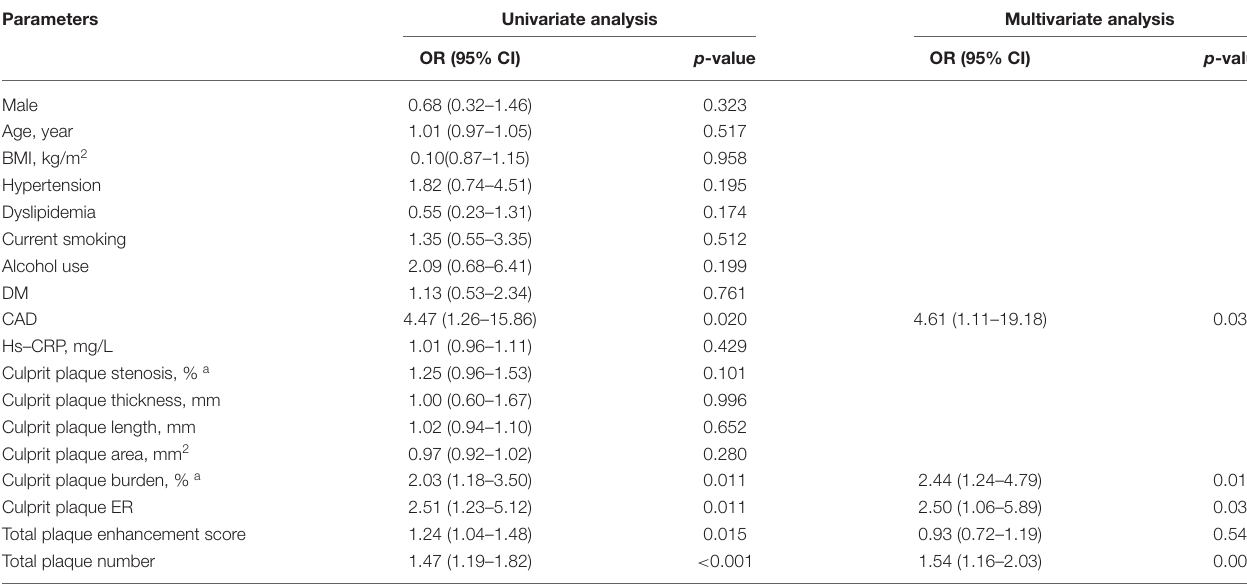
TABLE 3 | Univariate and multivariate analyses for factors associated with recurrent stroke in comparison with the first-time stroke.